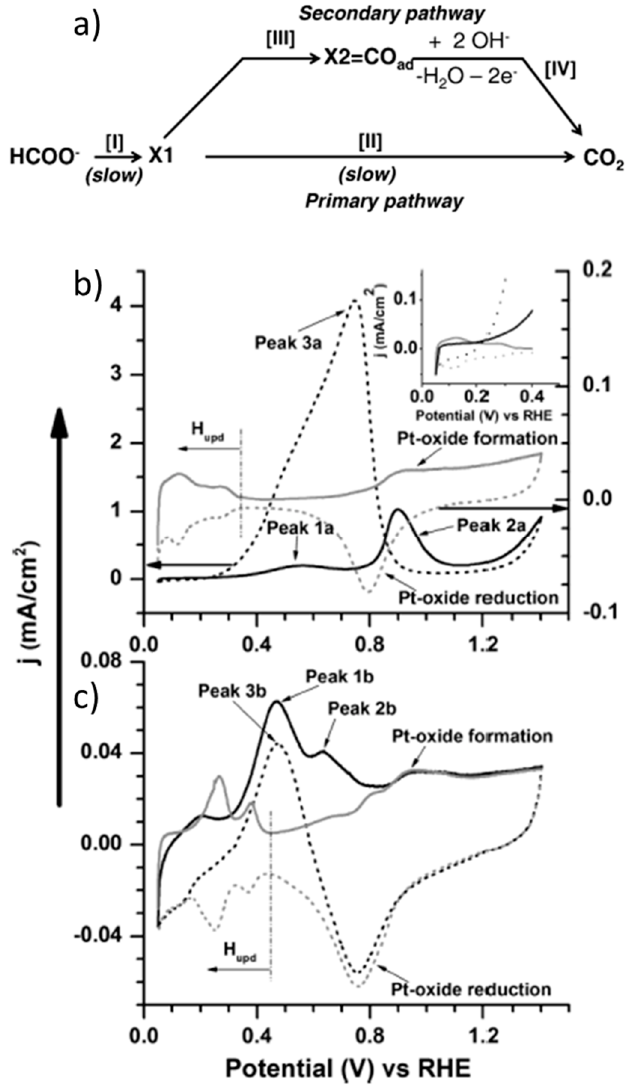
Figure 1. ( a ) Dual-pathway mechanism for HCOO − oxidation proposed by Ref. [40] Cyclic voltam- mograms, at 20 mV s − 1 , of Pt disk in ( b ) 1 M HClO 4 (grey); 0.2 M HCOOH + 1 M HClO 4 (black), and ( c ) 1 M NaOH (grey); 0.2 M HCOONa + 1 M NaOH (black). Solid and dashed lines represent the forward and reverse scans, respectively. Reprinted with permission form Ref. [40].